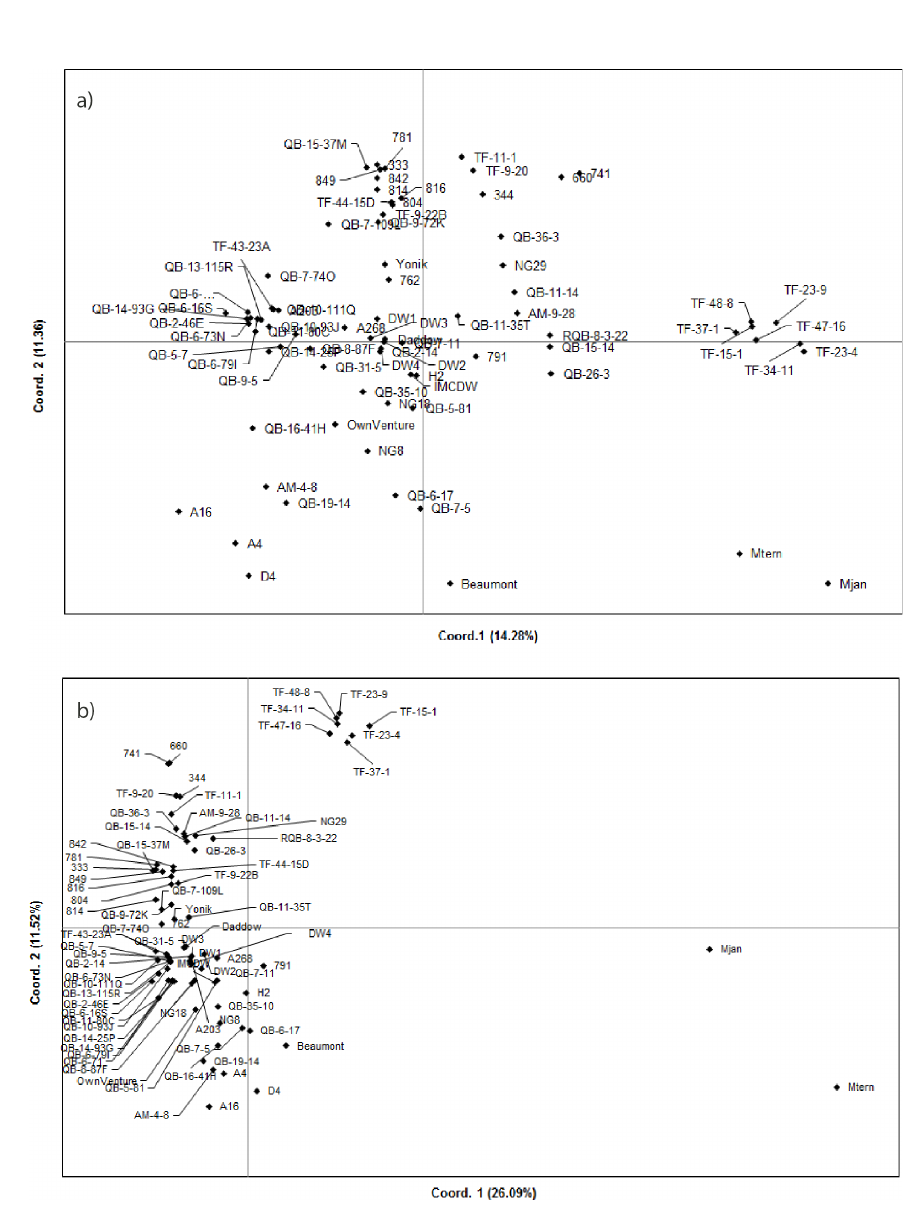
PLOS ONE | https://doi.org/10.1371/journal.pone.0203465 August 31,